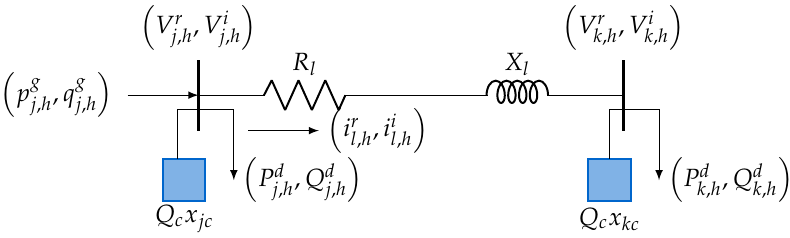
Figure 1. Representation of a distribution branch with the main variables of the MIQC